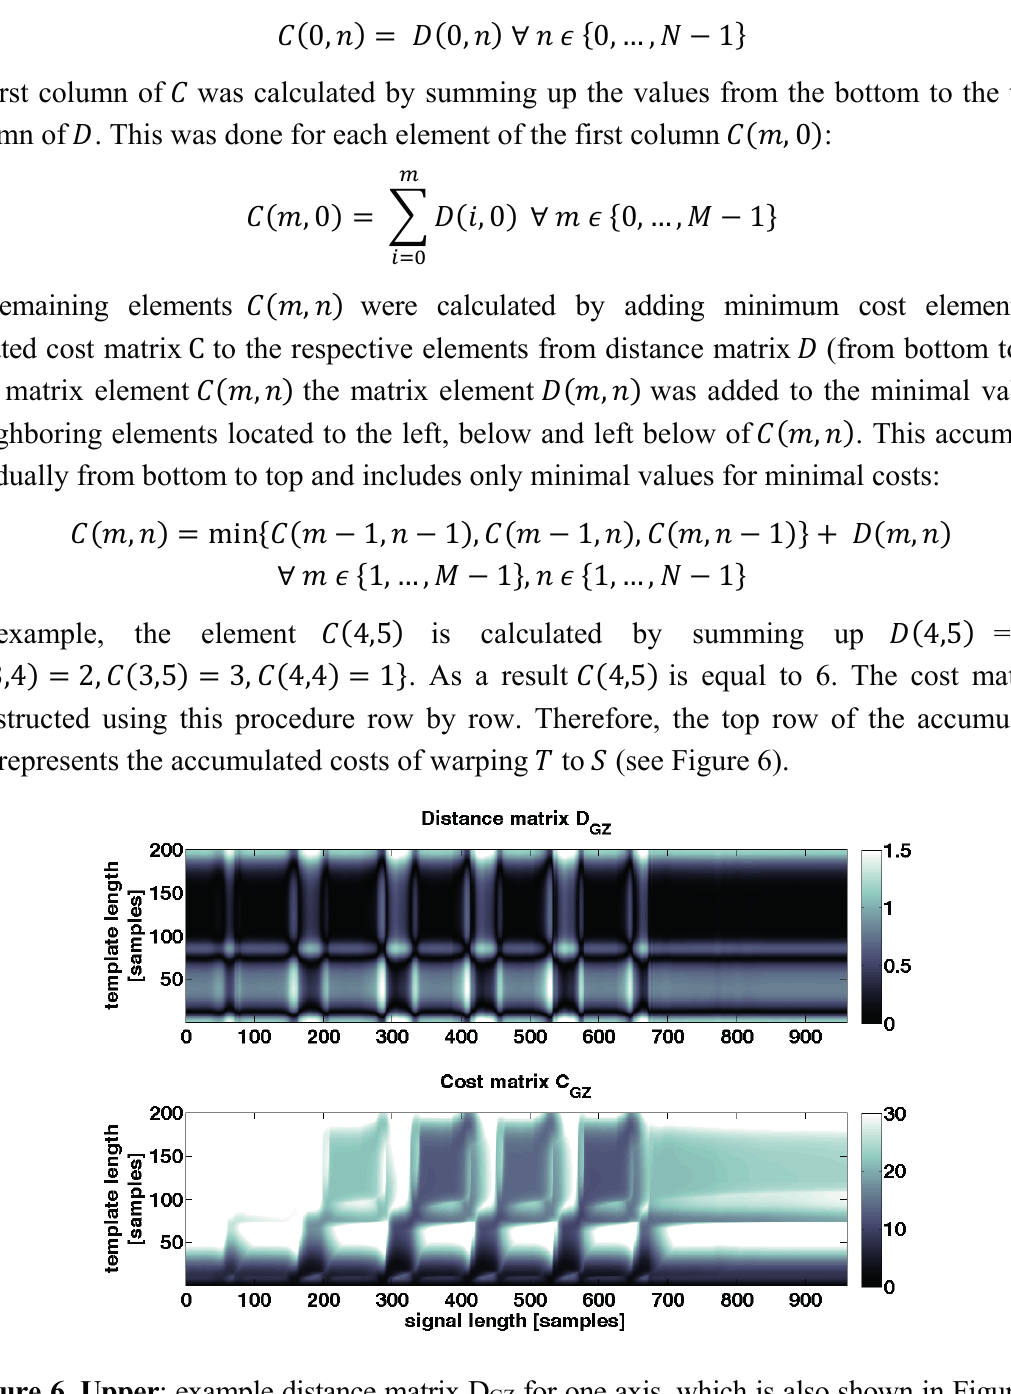
Figure 6. Upper : example distance matrix D GZ for one axis, which is also shown in Figure 5; Below : cost matrix C GZ which is calculated from D GZ . Deep black values in D GZ and C GZ show less distance and low costs between S GZ and T GZ . White values signalize a high distance and high costs. A path of deep black values from top to bottom signalizes a good warping of stride template (cid:1846) to movement sequence (cid:1845)